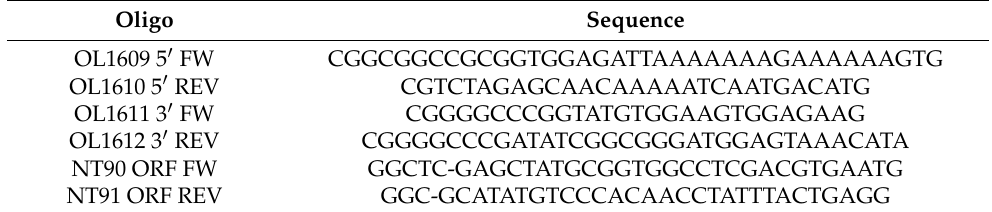
Table 1. Oligonucleotides used to generate constructs. Oligo